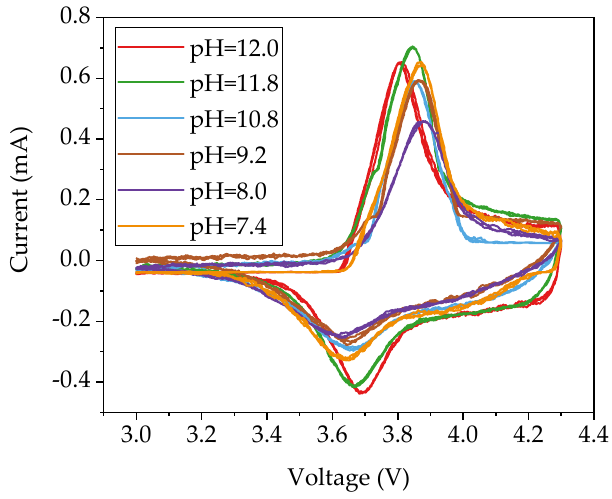
Figure 8. CV plots of cells containing cathodes that were produced with different slurry pH values.